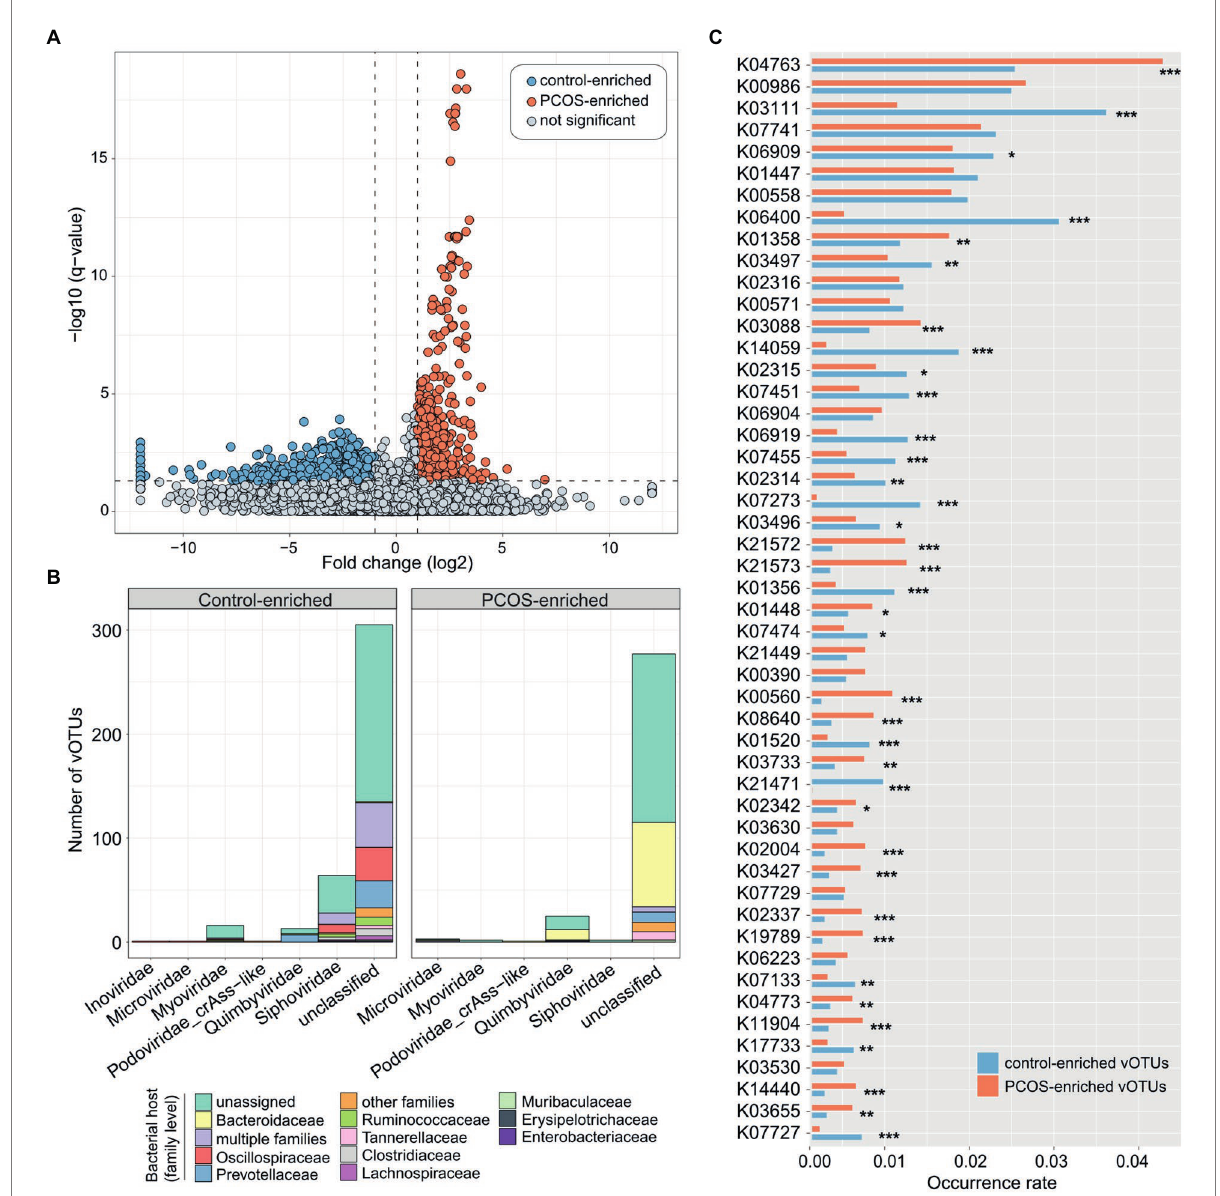
FIGURE 3 Polycystic ovary syndrome (PCOS)-associated viral signatures. (A) Volcano map showing the fold change and q -values of all vOTUs. vOTUs whose absolute value of fold change greater than 2 and q -value less than 0.05 were considered to be significantly different between PCOS patients and healthy controls, represented by blue and orange dots in the figure, respectively. (B) Bar accumulation plots showing the taxonomical and predicted host distributions of vOTUs enriched in the PCOS and control groups. Viruses that predicted to infect multiple bacterial families are labeled as “multiple families.” (C) Bar plot showing the occurrence rates of KEGG orthologs (KOs) in the PCOS-associated vOTUs. Only the top 50 KOs with the highest occurrence rates are shown. The significance level was calculated by Fisher’s exact test: * q < 0.05, ** q < 0.01, and *** q <